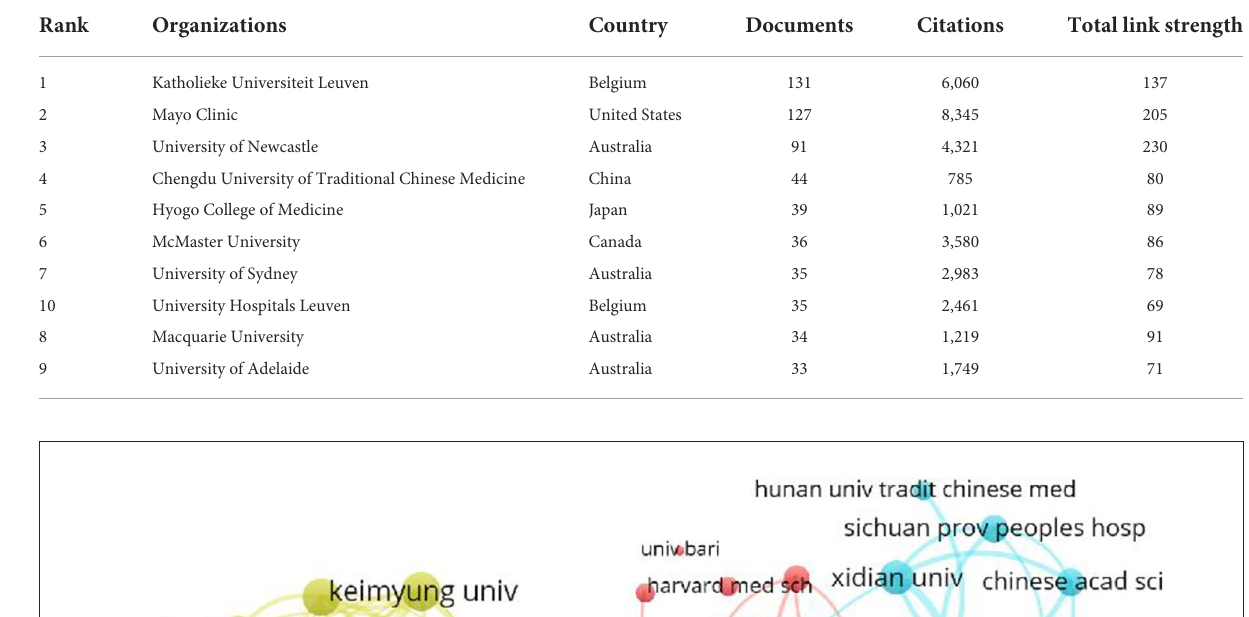
TABLE 2 Top 10 organizations about FD.